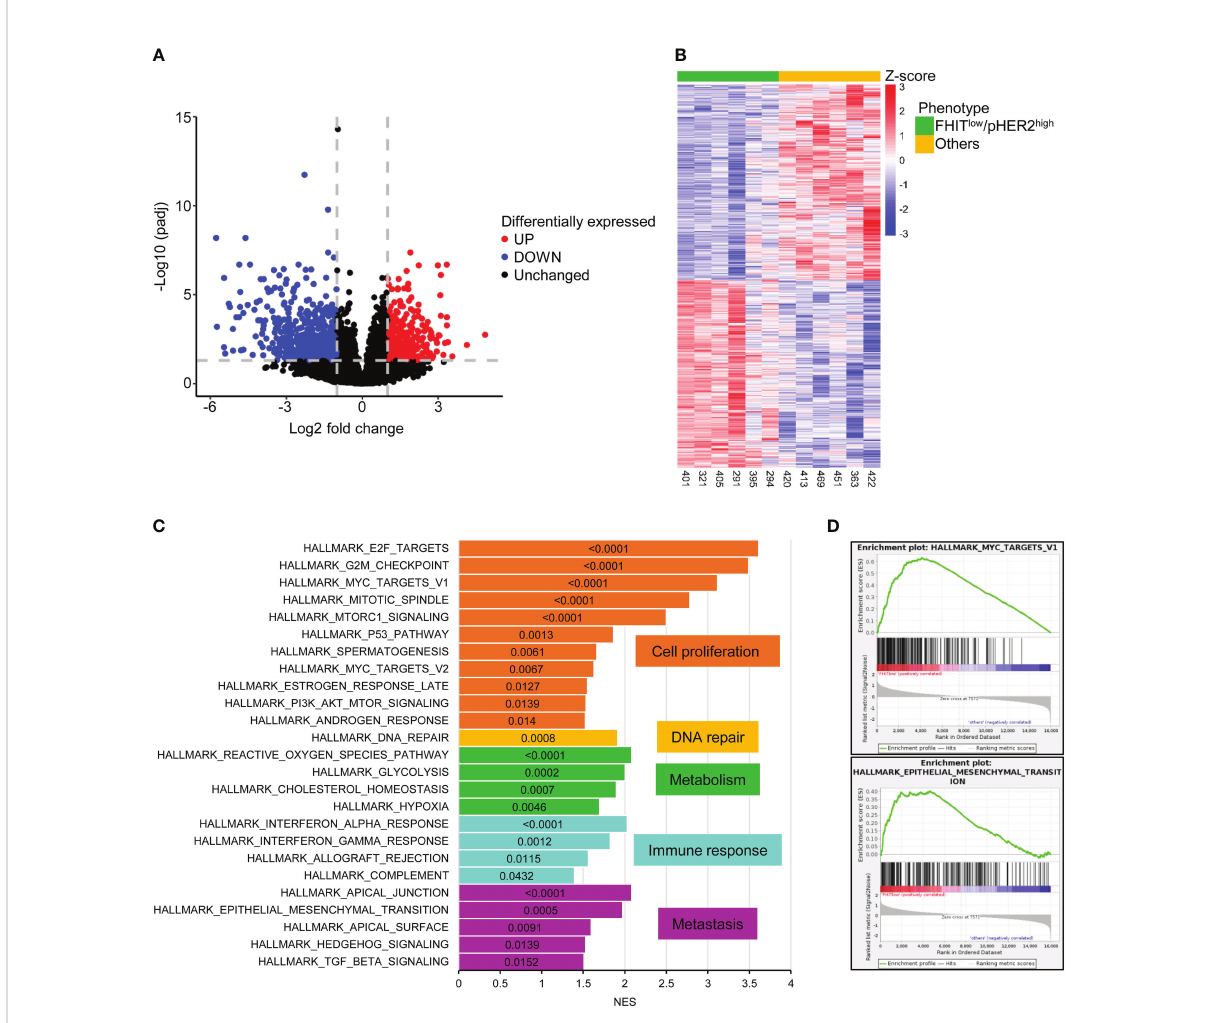
FIGURE 1 983 genes are signi fi cantly differentially expressed between FHIT low /pHER2 high and other tumors. (A) Volcano plot of statistical signi fi cance against fold-change in log2 scale between FHIT low /pHER2 high and other tumors highlighting the signi fi cantly downregulated genes in FHIT low / pHER2 high tumors in blue and the signi fi cantly upregulated genes in red. The gray horizontal dashed line corresponds to a False Discovery Rate (FDR) of 0.05 and the two vertical gray dashed lines correspond to a fold change of 0.5 and 2. (B) Heatmap of differentially expressed mRNAs. Scaled rlog transformed values are plotted in FHIT low /pHER2 high (green) against other (yellow) tumors. Each column represents a tumor, whereas each line represents a gene. Expression values by row (by gene) are centered so that the color re fl ects the amount by which each gene deviates in a speci fi c sample from the gene ’ s average across all samples. The tumors are clustered in an unsupervised hierarchical way. The top of the graph shows the sample ’ s membership. (C, D) Gene Set Enrichment Analysis (GSEA) was performed on all cancer hallmarks referenced in Msig database. Bar plot of the cancer hallmarks enriched in FHIT low /pHER2 high tumors (C) . Normalized Enrichment Score (NES) was plotted on the abscissa and the False Discovery Rate (FDR) corresponding to each enrichment test was written inside the bar of the corresponding hallmark. FDR < 0.05 was considered statistically signi fi cant. Hallmarks are grouped and colored depending on the cancer process they belong to. Enrichment of hallmarks of MYC targets V1 and Epithelial to Mesenchymal Transition (EMT) in FHIT low /pHER2 high tumors are shown (D)